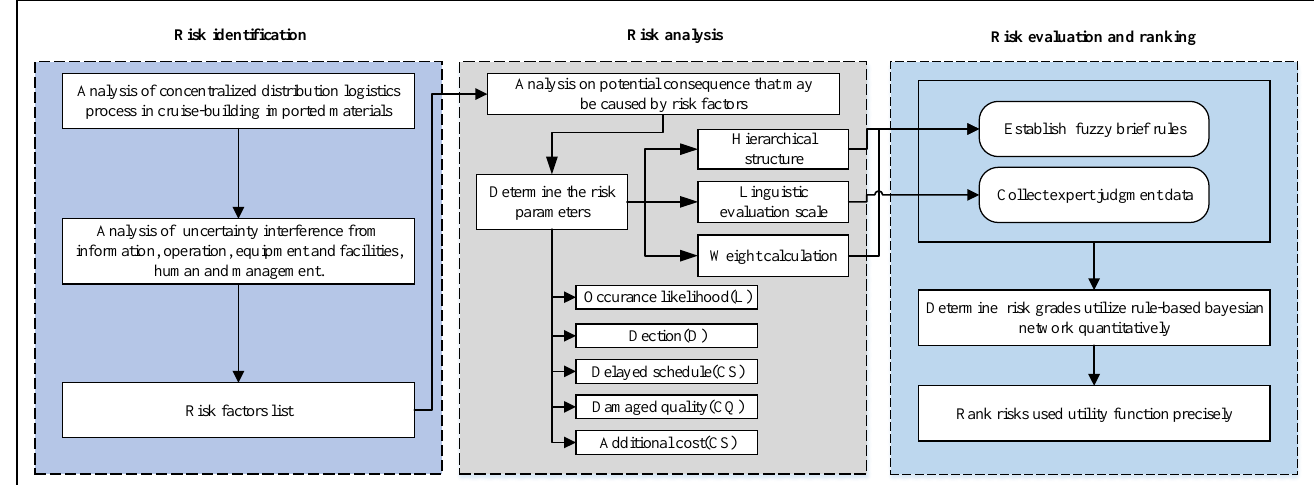
Figure 2. Methodological of risk assessment for CDL-CIMs.